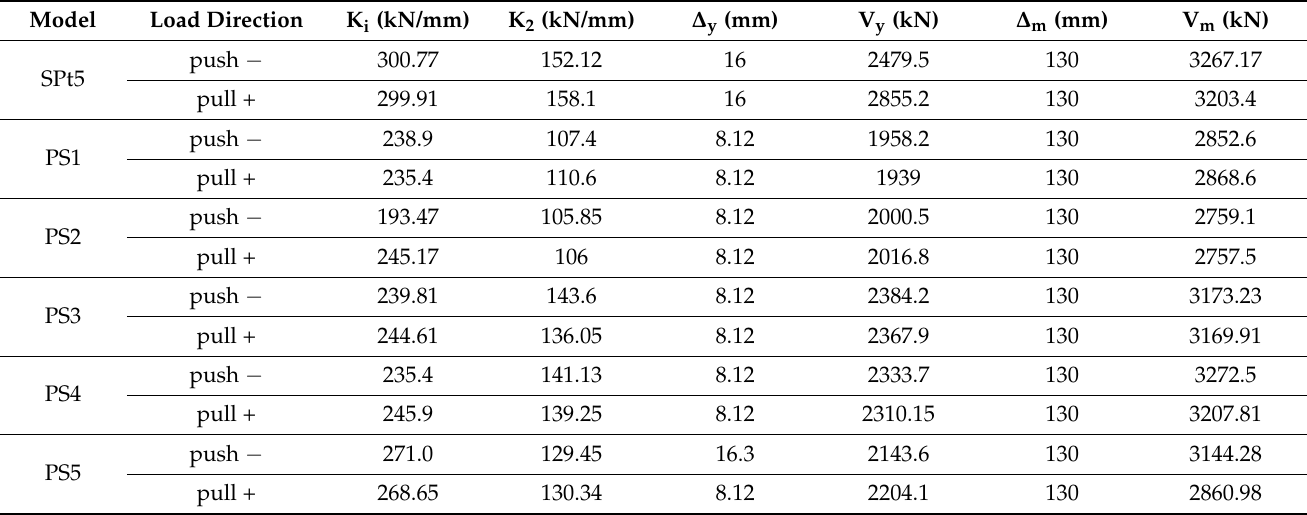
Table 3. Cyclic results of steel walls with different welding separation